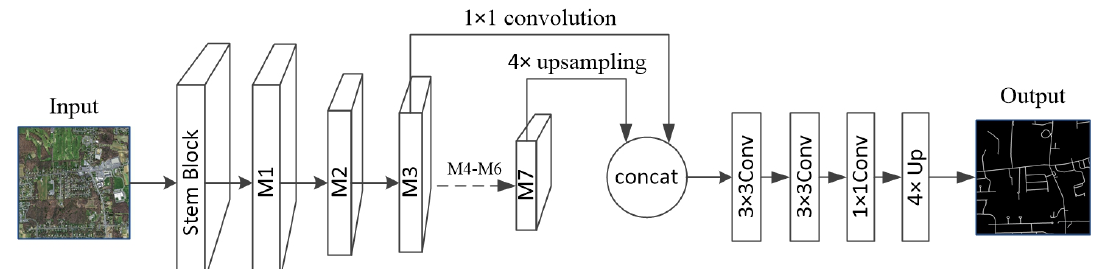
Figure 5. The student network framework is based on MobileNetV2. It is composed of seven basic blocks, M1, M2, ..., M7. The M3 feature map and a coarse bilinear interpolation upsampling of M7 are fused for combining the low-level spatial road information with abundant high-level semantic features. The next two 3 × 3 convolutional layers and one 1 × 1 convolution layer